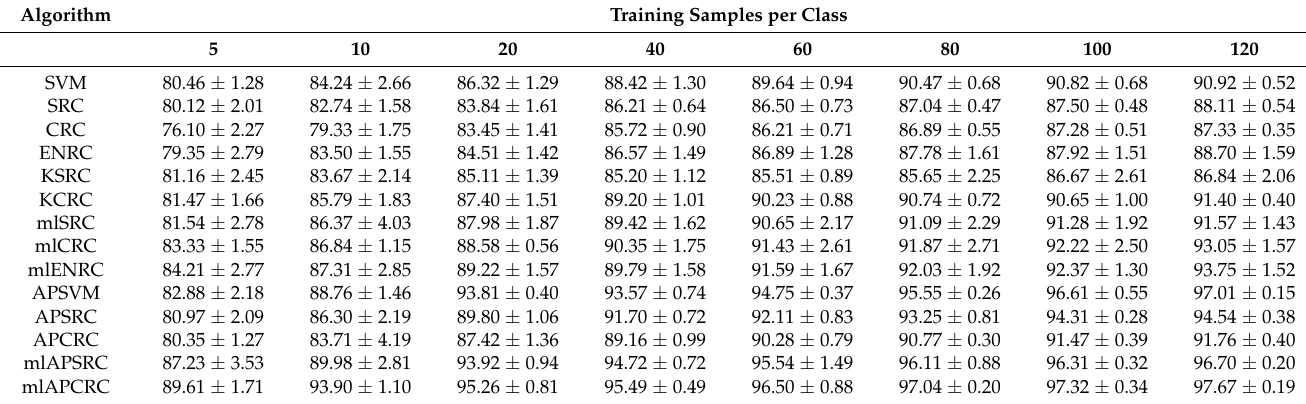
Table 7. Overall classification accuracy (%) and standard deviation as a function of the number of training samples per class for the Salinas image. Algorithm